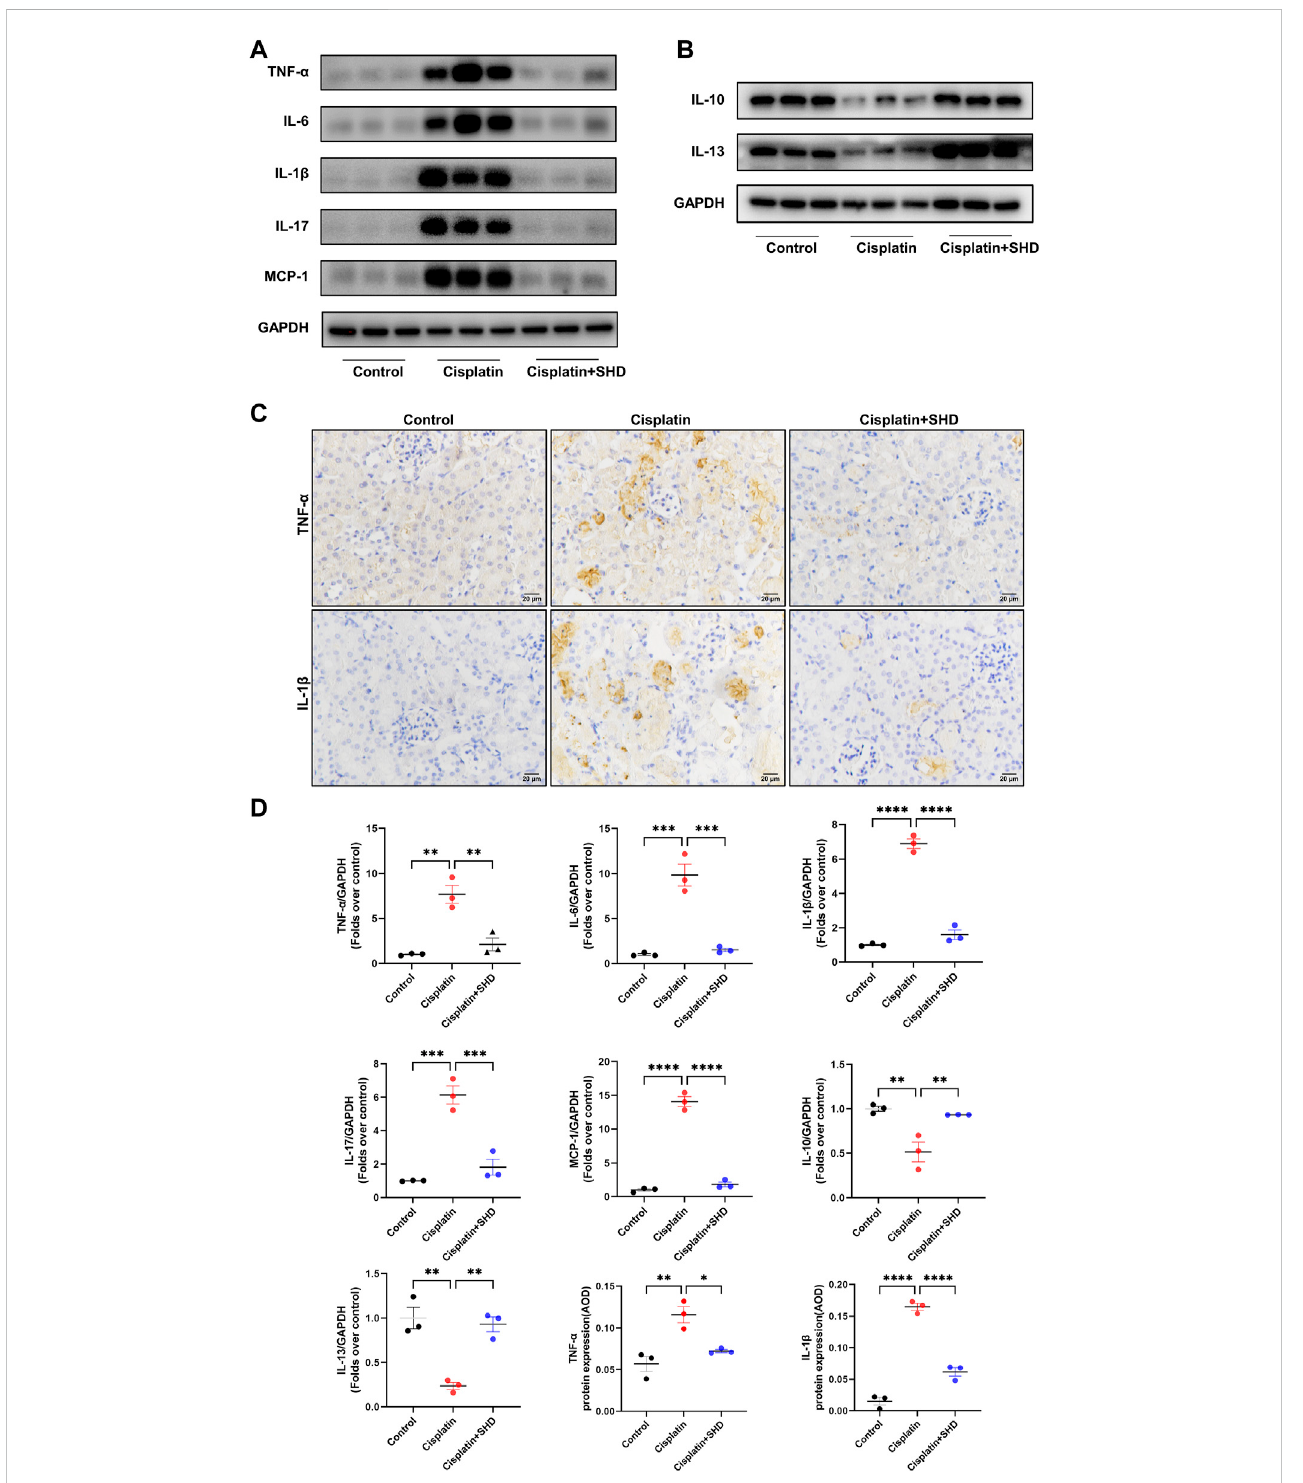
FIGURE 8 Effects of SHD on in fl ammation induced by Cisplatin in the kidney. (A) Representative Western blot images of pro-in fl ammatory cytokines, such as TNF- α , IL-6, IL-1 β , IL-17, and MCP-1 in the kidneys. (B) Representative Western blot images of anti-in fl ammatory factors, such as IL-13 and IL-10 in the kidneys. (C) RepresentativeIHCimagesofTNF- α andIL-1 β proteininrenalcorticalglomeruliandtubularepithelium.Scalebar=20 μ m (D) DensitometricanalysesofTNF- α ,IL-6,IL-1 β ,IL-17,MCP-1,IL-10andIL-13proteinsexpressionnormalizedtoGAPDHcontent( n =3).QuantitativeanalysisofIHCfortheTNF- α andIL-1 β protein expression. AOD = IOD/area. Data presented are means ± SEM. p p < 0.5, pp p < 0.01, ppp p < 0.001, pppp p <